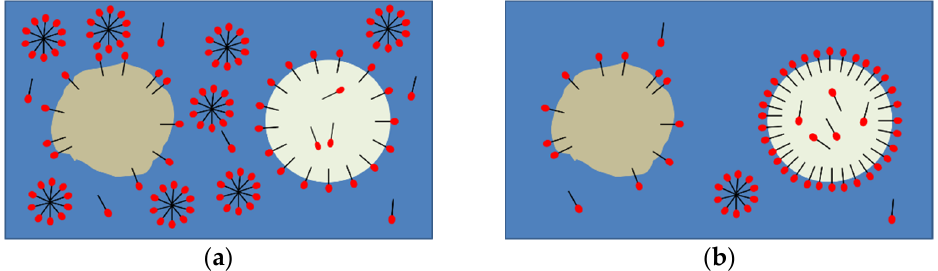
Figure 6. ( a ) Schematic system description when the surfactant was initially dissolved in the contin- uous phase (water). The subcooled droplet is presented in a light color, the solid particle is shown as a brown sphere. ( b ) Schematic system description when the surfactant was initially dissolved in the dispersed phase (n-hexadecane). Both systems had not yet reached the thermodynamic equilib-